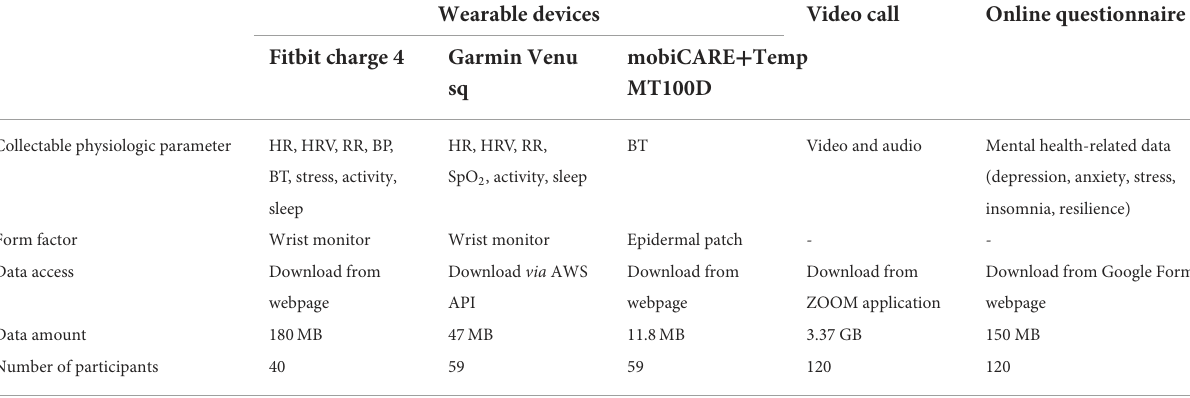
TABLE 3 Multimodal data acquisition with wearable devices, video calls, and online questionnaires.